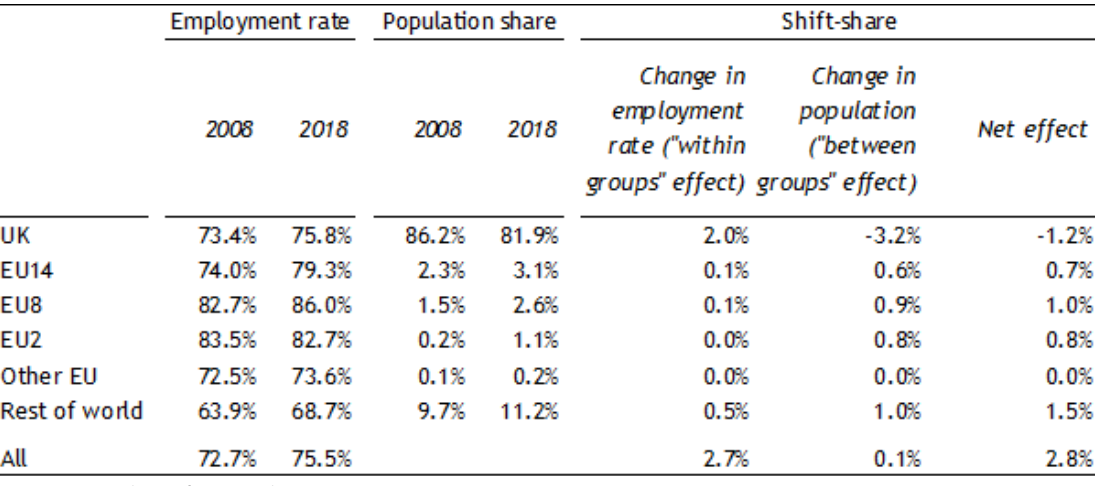
Table 4: Employment and population changes by country of birth, 16-64 year olds: